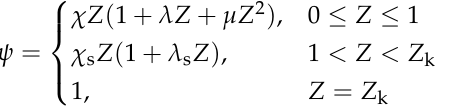
Figure 7. Movement process of the projectile.